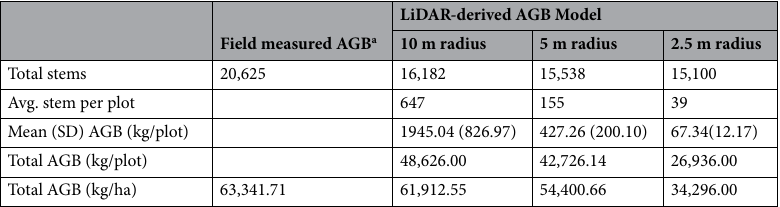
Table 9. The AGB computed by Model II in various plot sizes. a Computed by the Pantropical Model 2 (Model 2, as shown in Eq. (4)).